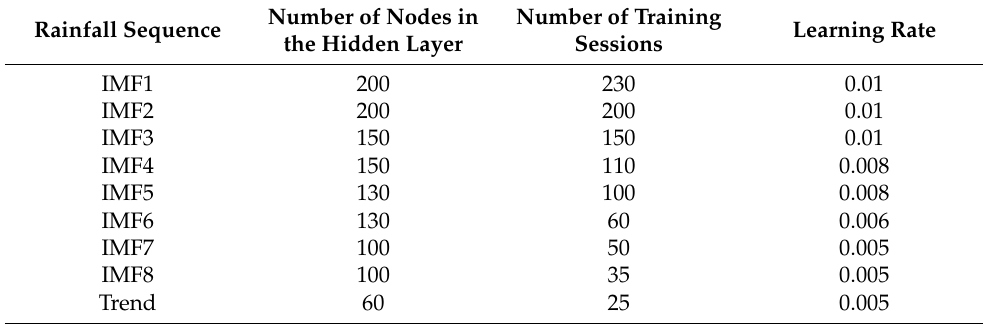
Table 3. Parameters corresponding to the LSTM model.